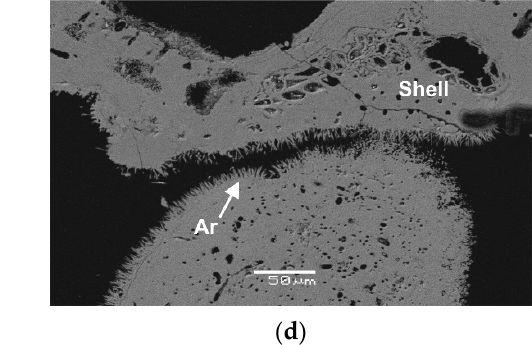
Figure 10. SEM images of sample ArSum1 ( a ) well-developed crystals of aragonite cover the sediment grains and ( b ) crystals of aragonite and matrix cement work as pore filling in a foraminifera shell. SEM images of sample ArSum2 ( c ) well-developed crystals of aragonite biding two sediment grains, ( d ) general view of particles coated by aragonite crystals. Ar stands for aragonite.